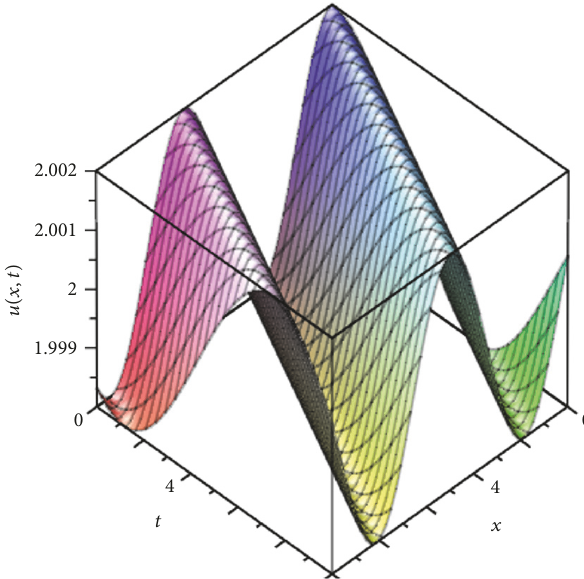
Figure 3: 3D plot of (46) with 𝑎 0 = 1 , 𝑎 1 = 1.1 , 𝑎 2 = 0.57 , 𝛾 = 1 , 𝛼 = 0.5 , 𝛽 = 0.7.